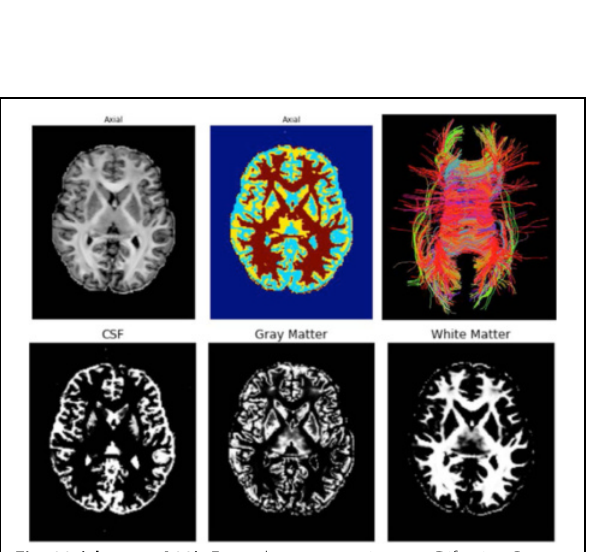
Fig. 22 (abstract A23). Example segmentations on Difussion Power Maps